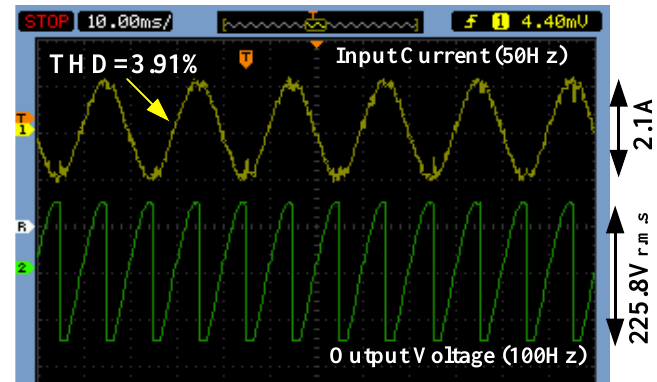
Figure 18. Experimental results of output voltage w.r.t. input current (Scale: Output voltage, 75 V/div; input current, 1 A/div; and Time, 10 ms/div).